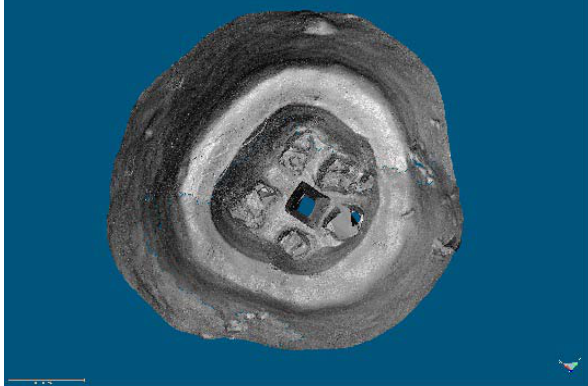
Figure 8. The 3D model of the Lapidarium